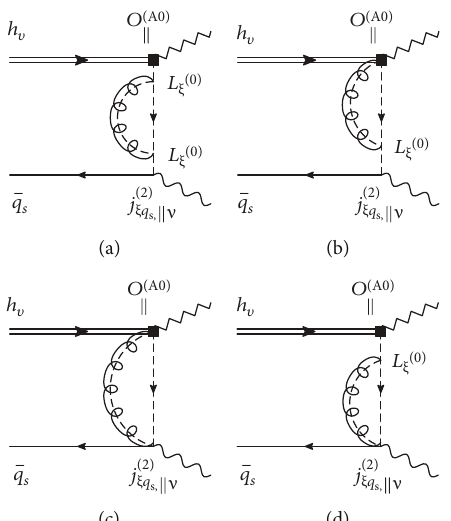
fi ned with the A 0 -type SCET operator ν , ∥ ð p , q Þ de